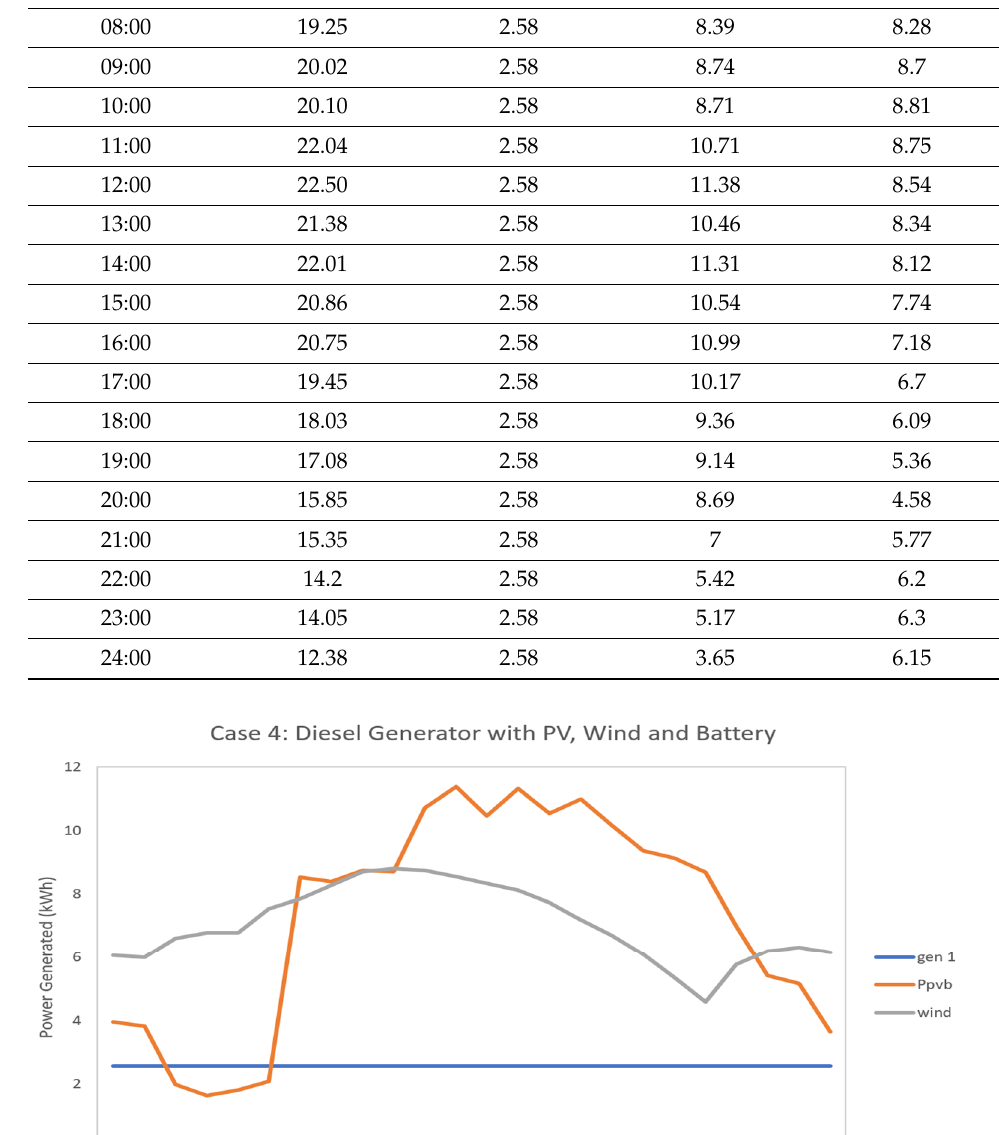
Figure 10. Case 4: Performance evaluation of economics and emissions. 5. Conclusions The main aim of this paper was to evaluate the impacts of a hybrid energy system that includes diesel generators, solar PV, wind turbines and a battery storage system uti- lizing different system configuration to meet the required load demand of rural healthcare facilities. The objective was to minimize the operational cost and emission from the diesel generators. The multi-objective optimization model developed was solved using Alge- braic Modeling Language. Four different configurations were used to assess the economic and environmental performance of the proposed model. This research is proposed to as- sist decision makers in planning a cost-effective sustainable energy system for the proper operation of a healthcare center in a rural community in Nigeria. The results obtained from this paper indicate the impact of the incorporation of renewable energy sources on